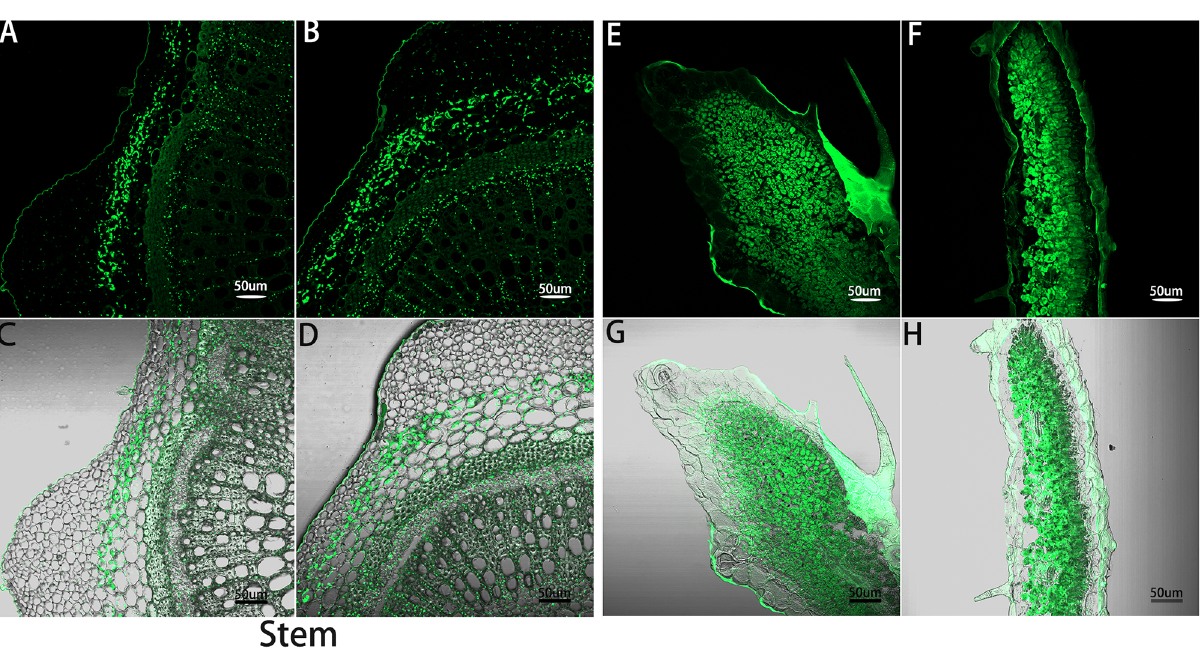
Figure 8. Leaves and stems were stained with NA solution and observed with CLSM (50 µm). The figure showed the distribution of flavonoids in the cross section of S. miltiorrhiza after staining. (A,B,E,F) indicated the distribution of flavonoids in the AF488 channel. (C,D,G,H) Indicated the distribution of flavonoids in superimposed bright field of AF488 channel. (A,C) Indicated the purple stem. (B,D) Indicated the green stem; (E,G) indicated the leaf with purple edge. (F,H) Indicated the green